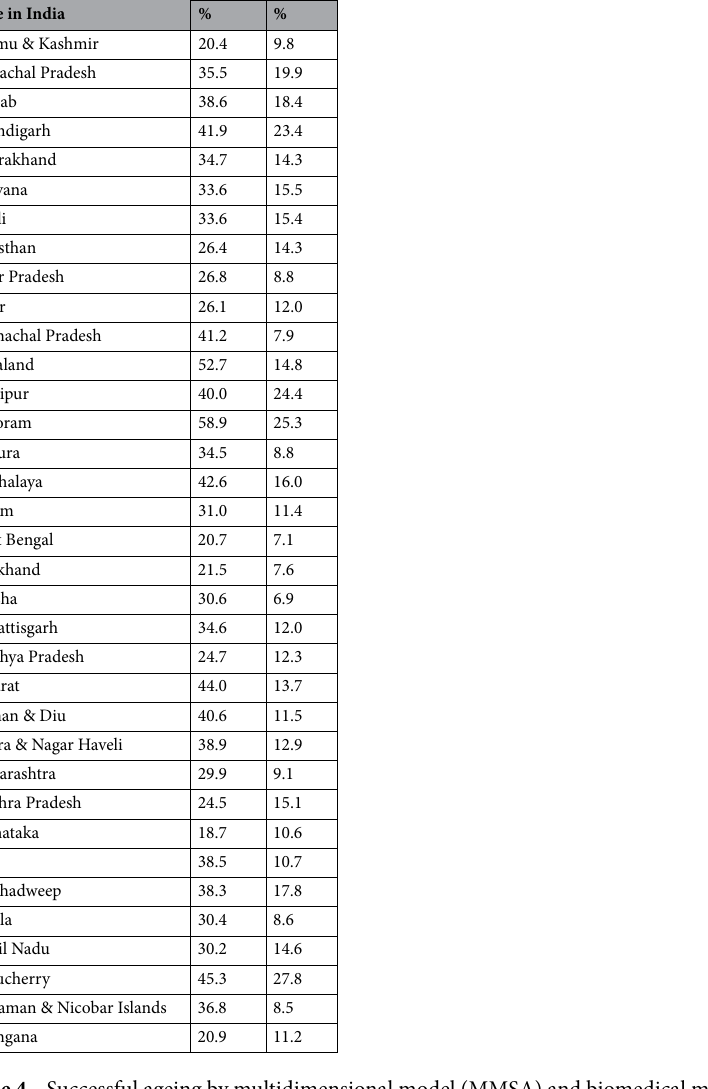
Table 4. Successful ageing by multidimensional model (MMSA) and biomedical model (BMSA) by state (N =